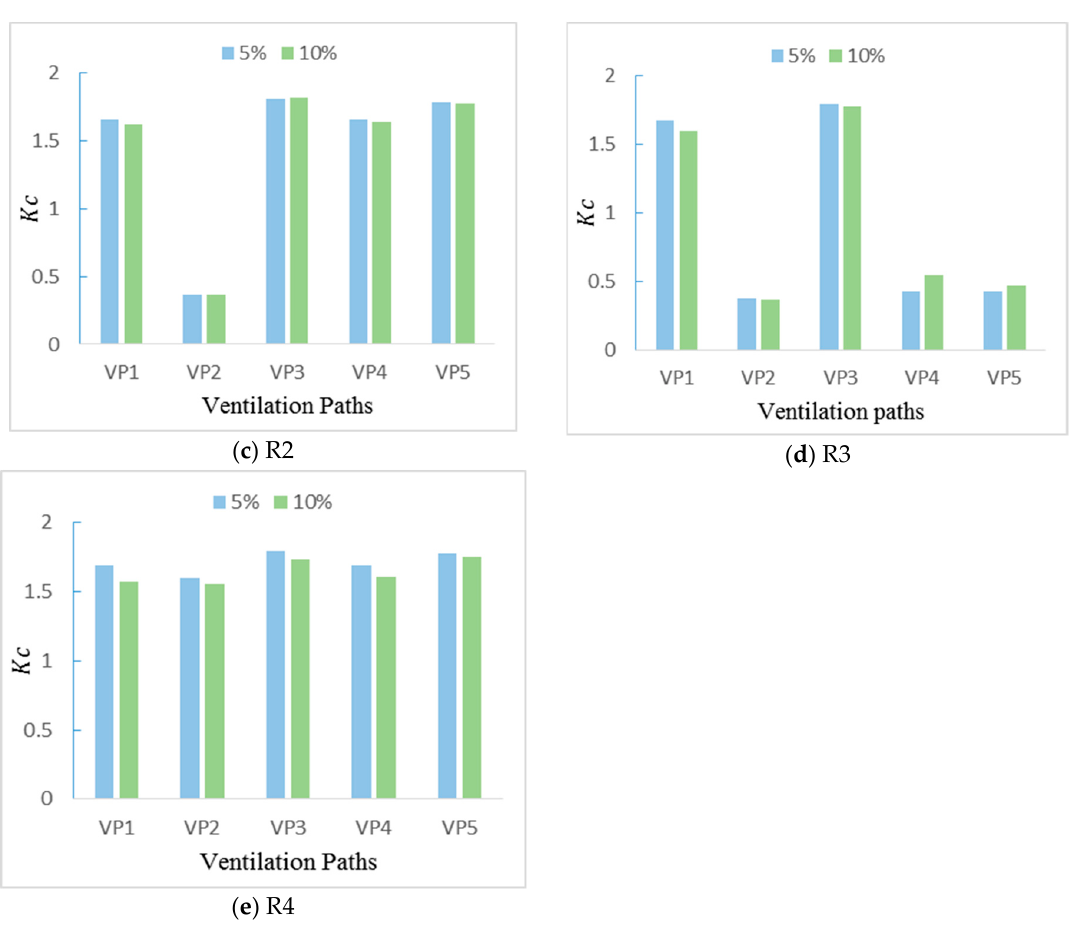
Figure 9. Non-dimensional concentration (K c ) at the z = 1.2 m cross-section in each room under five ventilation paths. ( a ) Building-averaged concentration; ( b ) R1; ( c ) R2; ( d ) R3; ( e ) R4.